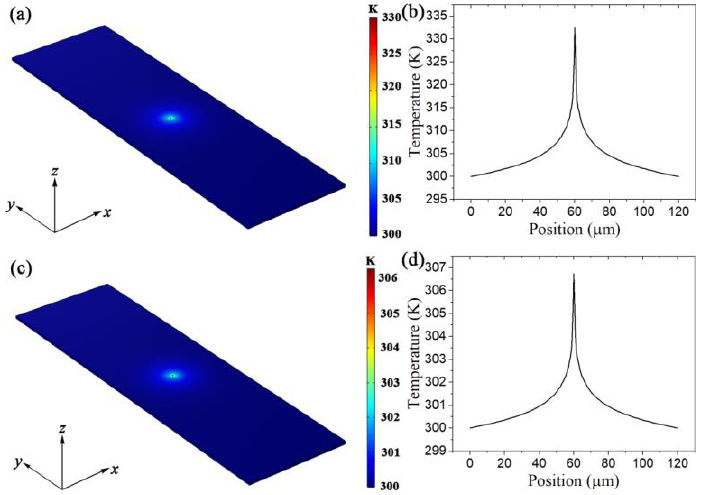
Figure 5. Simulated in-plane temperature distribution for ( a ) Sample 1, and ( c ) Sample 2. The temperature distributions of ( b ) Sample 1 and ( d ) Sample 2 along x axis at the center.